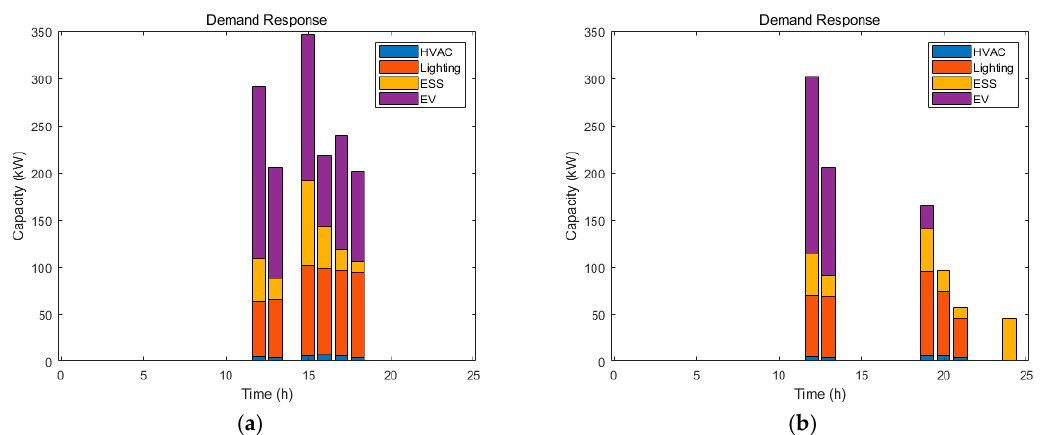
Figure 12. Optimal DR capacity scheduling results in ( a ) summer; ( b ) winter.